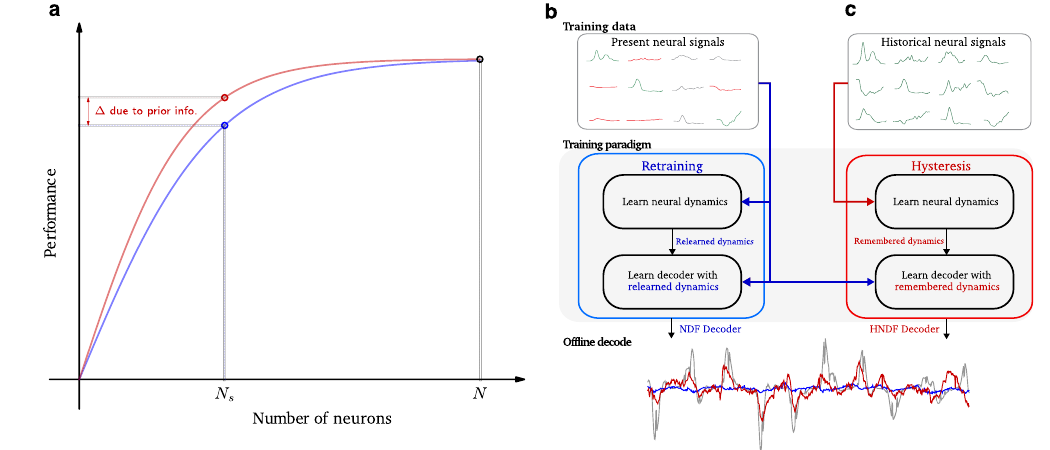
Figure 1. Decoder hysteresis and exploiting neural dynamical invariance. ( a ) Illustration of the decoder hysteresis concept. The blue curve represents the hypothetical drop off in performance in the scenario where neural recording electrodes are lost and a decoder is retrained naïvely with the remaining neurons. The red curve illustrates the idea of using prior information regarding motor cortex, specifically knowledge about neural dynamics, to augment the decode algorithm and mitigate the loss of performance as neurons are lost. ( b ) Block diagram for retraining with remaining neural signals. The present neurons are used to retrain a decode algorithm, which involves neural systems identification and decoder parameter learning to predict kinematics. When decoding withheld testing data to reconstruct a monkey’s hand velocity in the horizontal direction (gray trace), the retrained decoder (blue trace) poorly reconstructs the hand velocities. ( c ) Block diagram for decoder hysteresis. A historical dataset is used to identify neural dynamics of motor